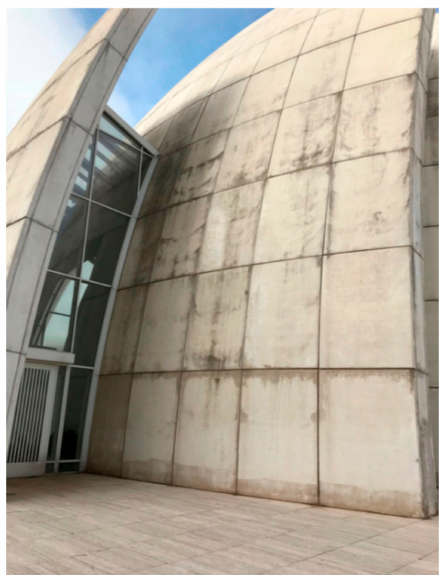
Figure 37. View of the damages on the surface of the self-cleaning concrete shells of Jubilee Church in Rome, which were caused by the local environmental dust. Reprinted with permission from [180]. Copyright © 2019, Taylor & Francis